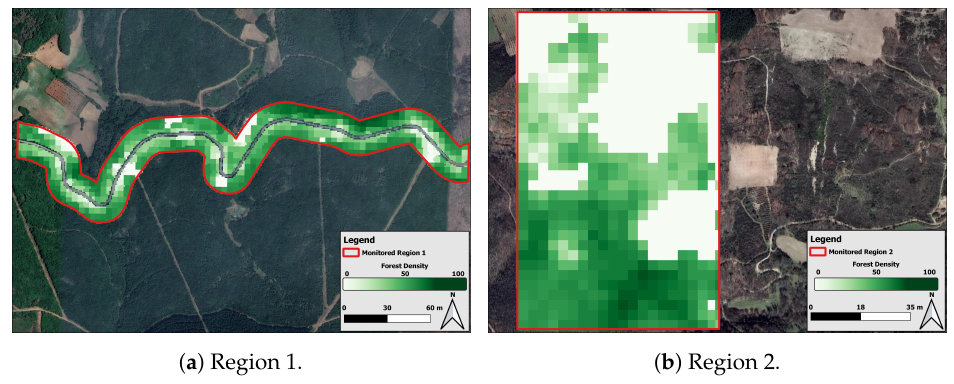
Figure 3. Forest density maps of the forest